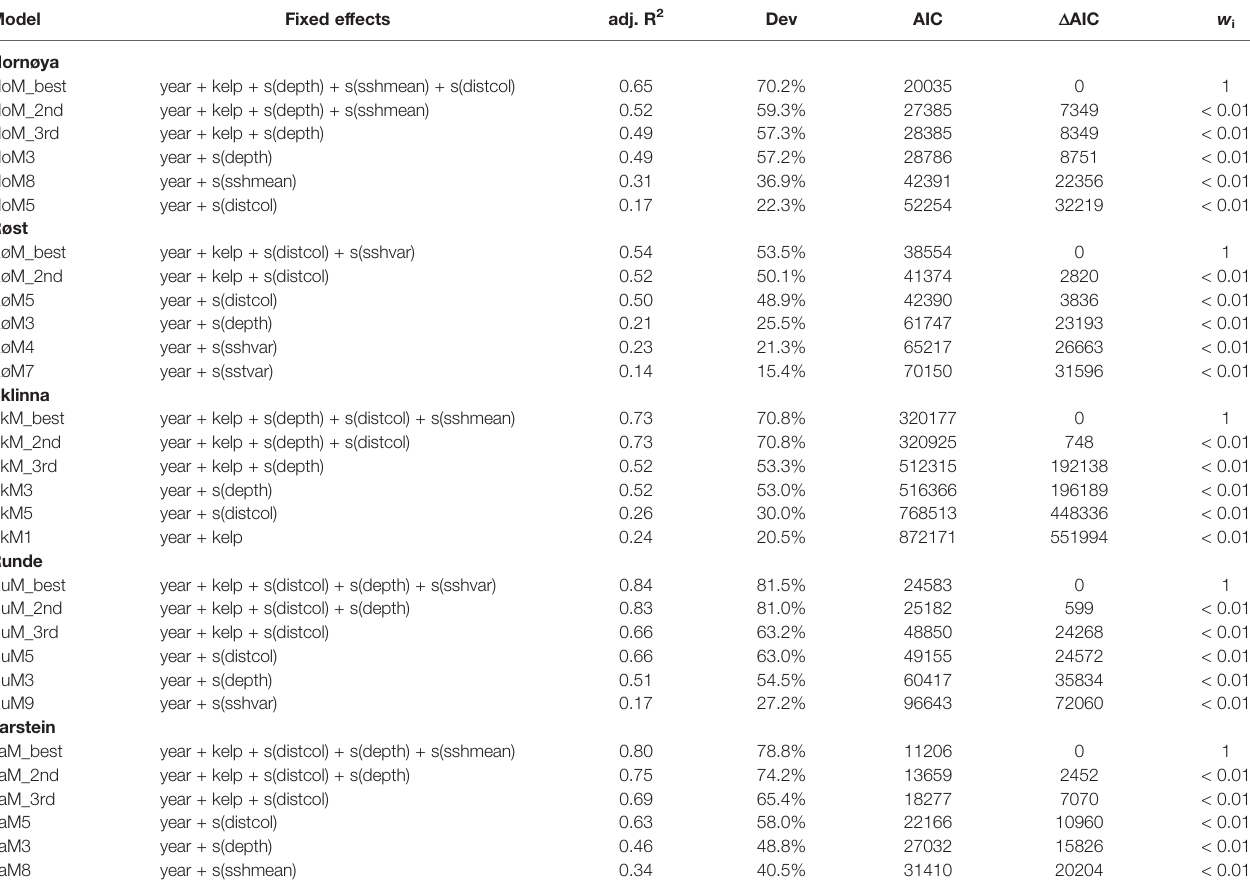
TABLE 2 | Summary of the model selection process.